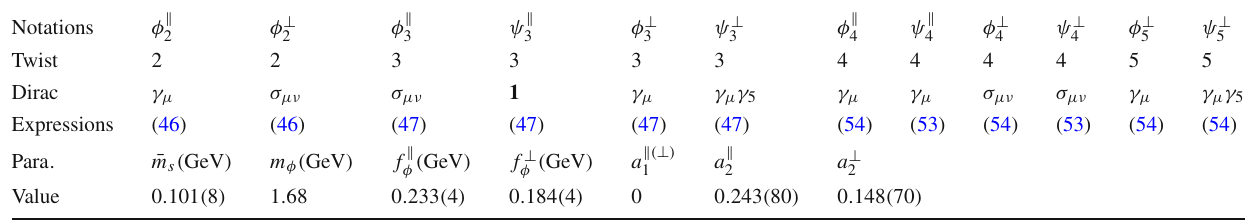
Table 4 Notations of the LCDAs of light vector mesons (up tabular) and nonperturbative parameters at the factorization scale μ f = 1 . 66GeV of the φ meson LCDAs taken in our evaluation (low